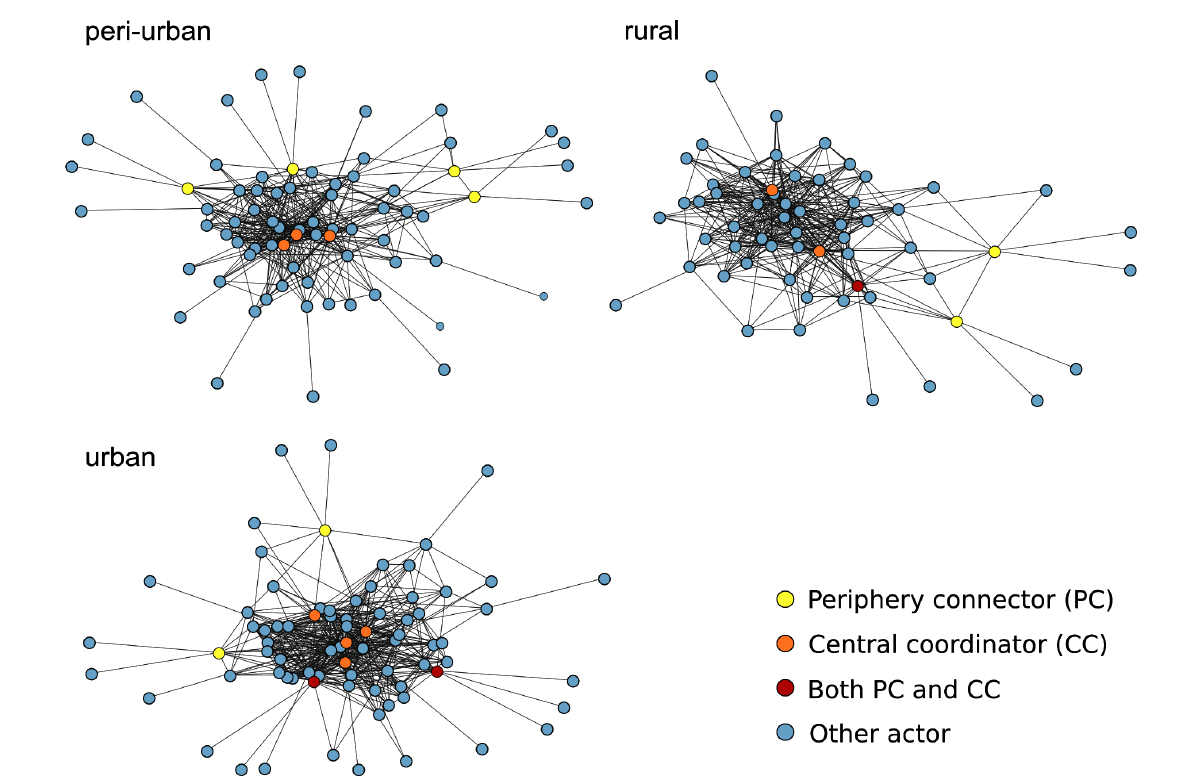
Fig. 2 . Collaboration networks in water supply for three regions in the Swiss canton of Basel-Landschaft. Colors indicate periphery connector and central coordinator